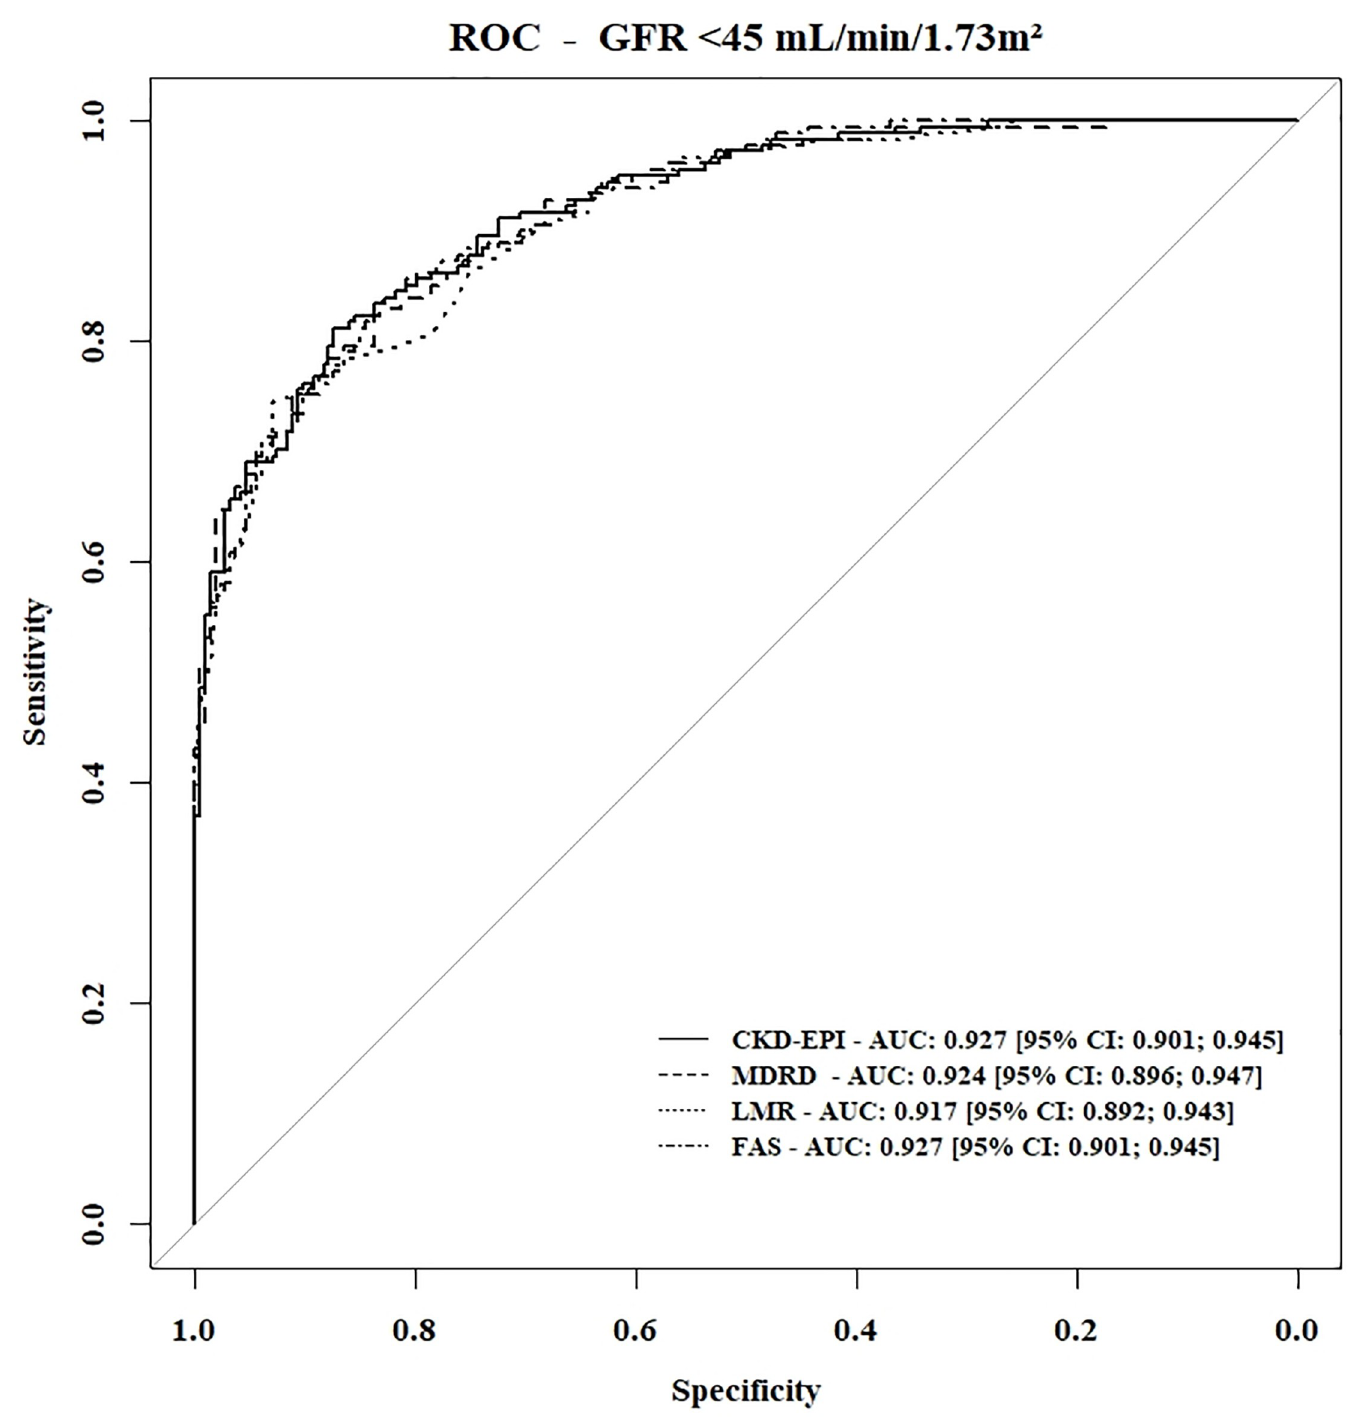
Fig 4. Receiver Operating Characteristic (ROC) analysis for the ability of the different GFR estimating formulas CKD-EPI, MDRD, LMR and FAS to detect mGFR < 45 mL/min/1.73 m 2 . Abbreviations: CKD-EPI, Chronic Kidney Disease–Epidemiology Collaboration; MDRD, Modification of Diet in Renal Disease Study; LMR, Lund-Malmo¨ Revised; FAS: Full Age Spectrum; CI: confidence interval.